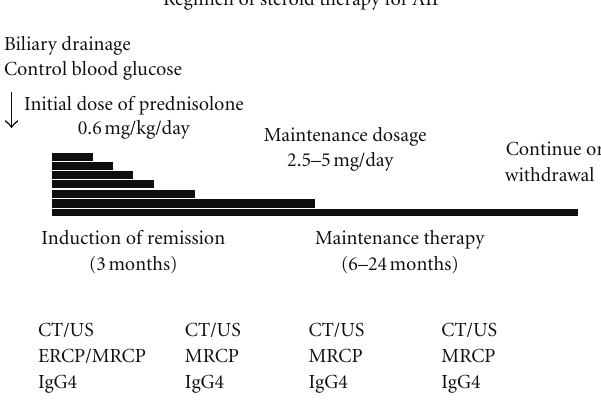
Figure 1: Regimen of oral steroid therapy for